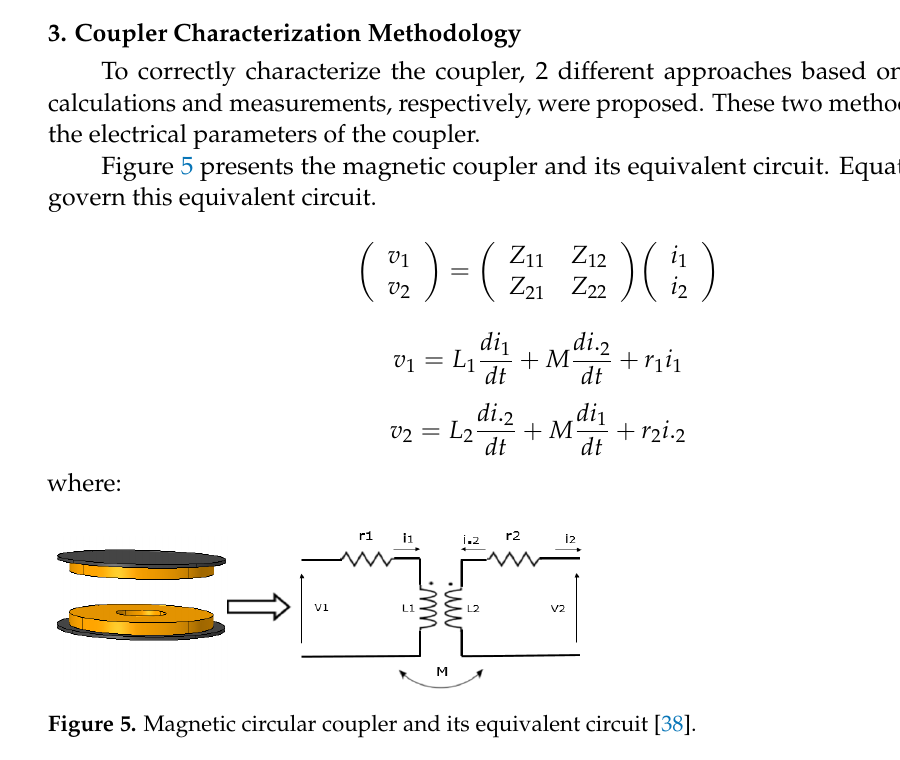
Figure 5. Magnetic circular coupler and its equivalent circuit [38].